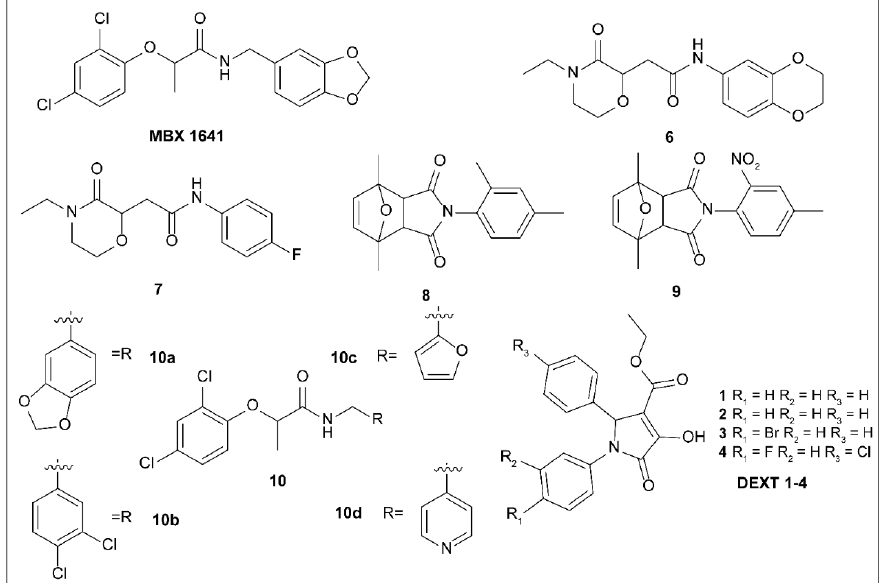
Figure 4. Structures of phenoxyacetamides, 10a - d , and DEXT 1-4.